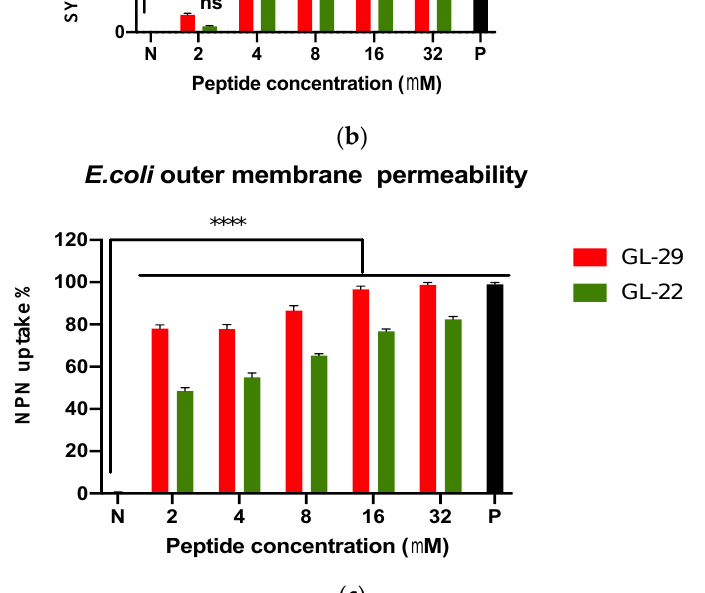
Figure 4. The membrane permeabilisation of ( a ) S. aureus (ATCC CRM 6538) and ( b ) E. coli (ATCC CRM 8739) and ( c ) outer membrane permeabilisation of E. coli (ATCC CRM 8739) with GL-29 and GL-22 at concentrations of 2 µ M, 4 µ M, 8 µ M, 16 µ M and 32 µ M. P and N represent positive control and negative control. Melittin (16 μ M) was employed as a positive control. The negative control was bacterial cell suspension with no treatment. The percentage of permeability was calculated by comparison with the negative control group. The error bars represent means with SEM of nine repeats from three independent tests. The statistical significance was analysed using two-way ANOVA by comparison with the negative control group and is indicated as ns (non-significant difference), ** ( p < 0.01), **** ( p < 0.0001).